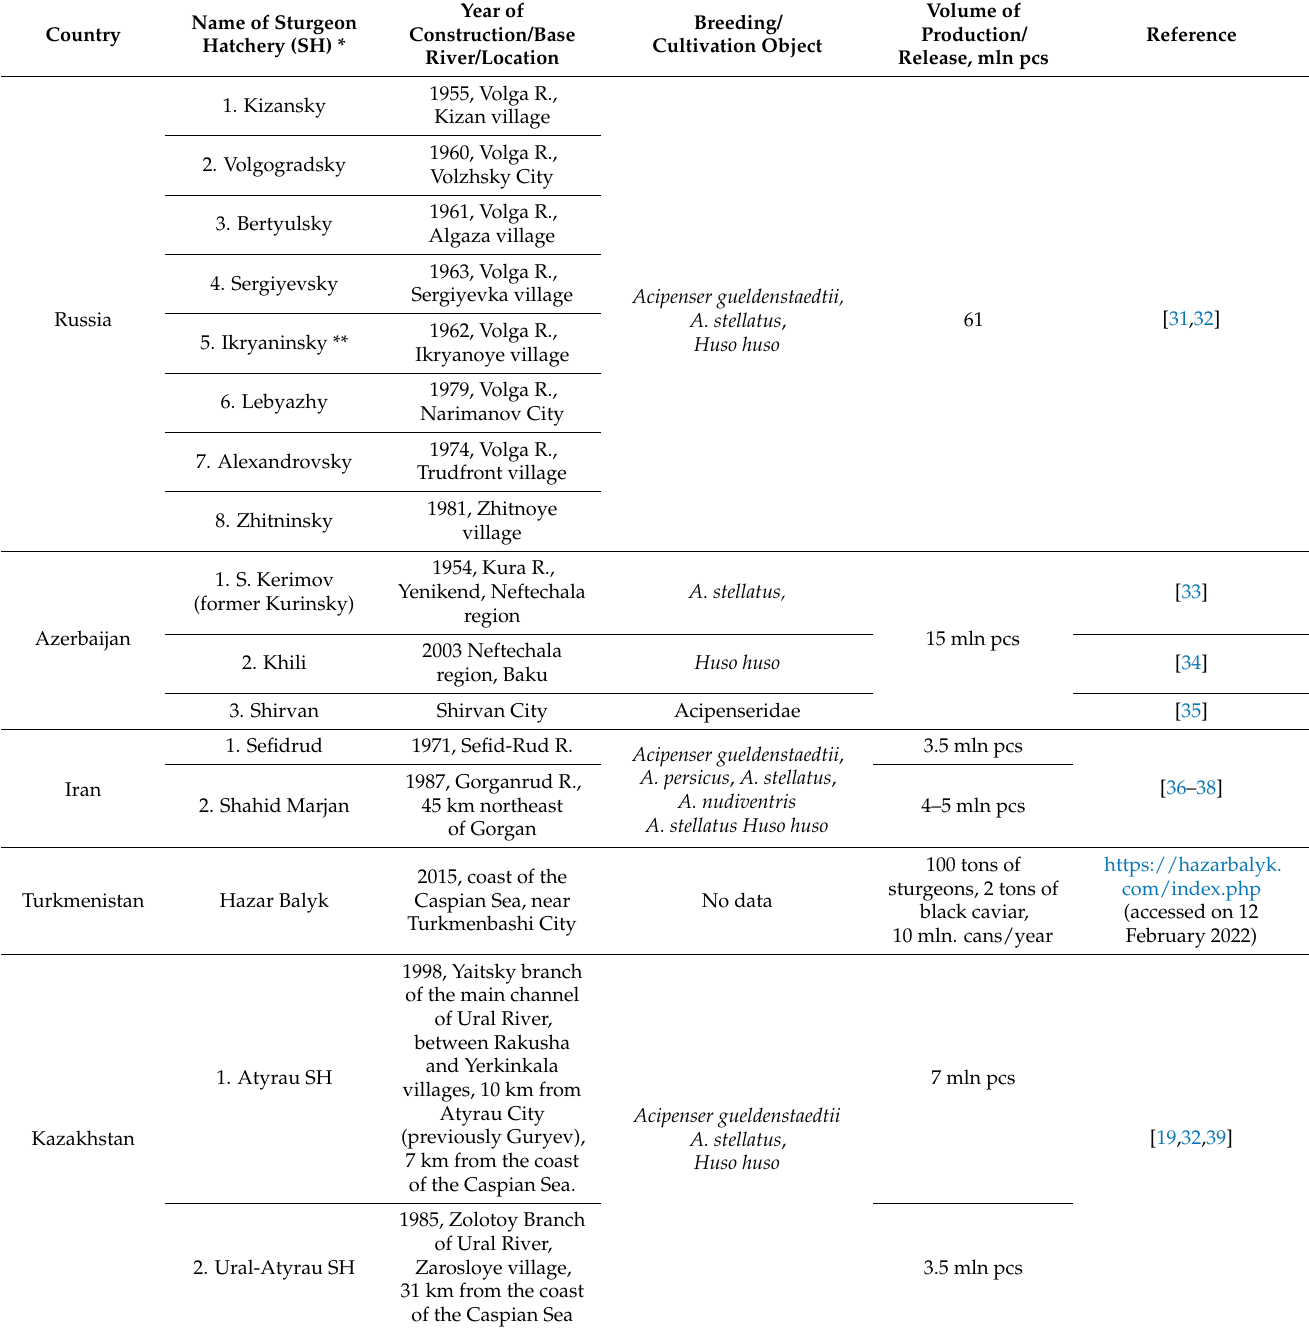
Table 1. Sturgeon hatcheries of the Caspian states (Russia, Azerbaijan, Iran, Turkmenistan,